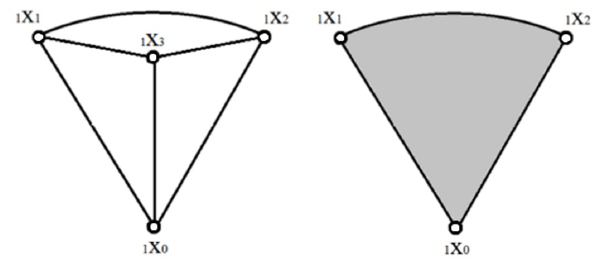
Figure 11. Piezoelectric stack model that consists of two piezoelec- tric plates powered by separate electrical circuits.